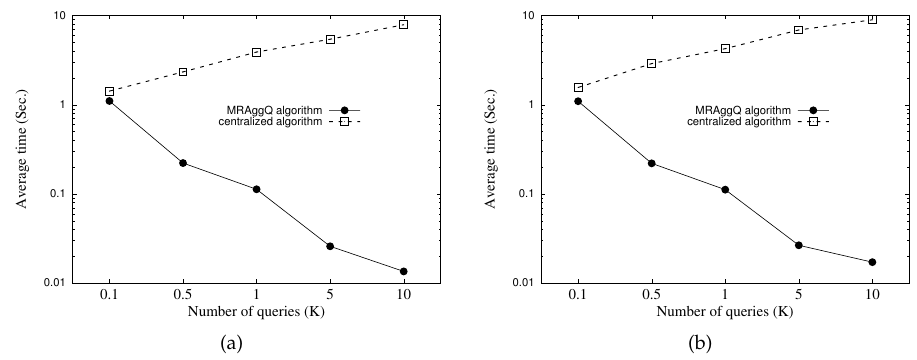
Figure 12. Effect of the number of queries. ( a ) Uniform dataset; ( b ) Manchester